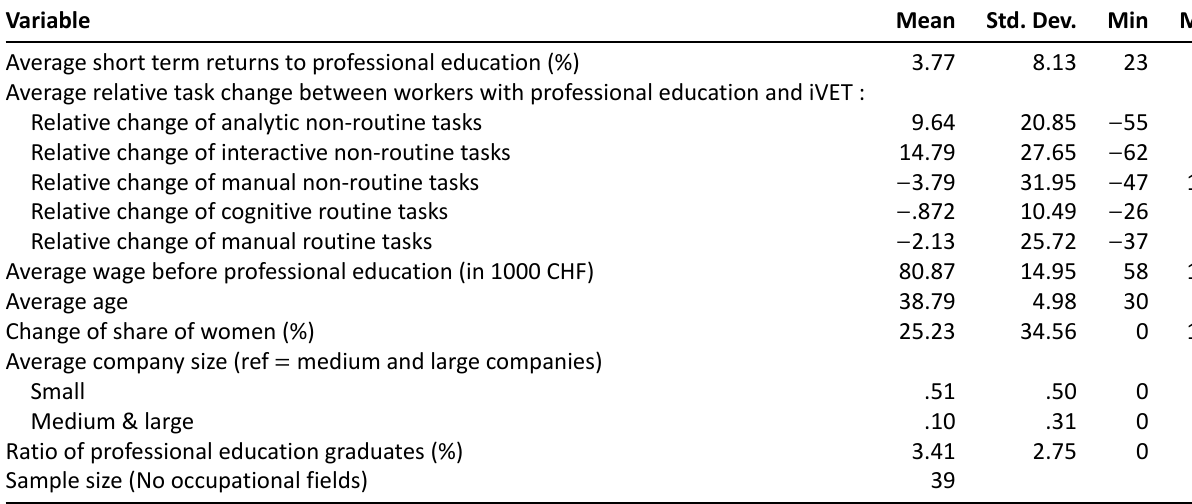
Table 2. Descriptive overview of variables for model II.